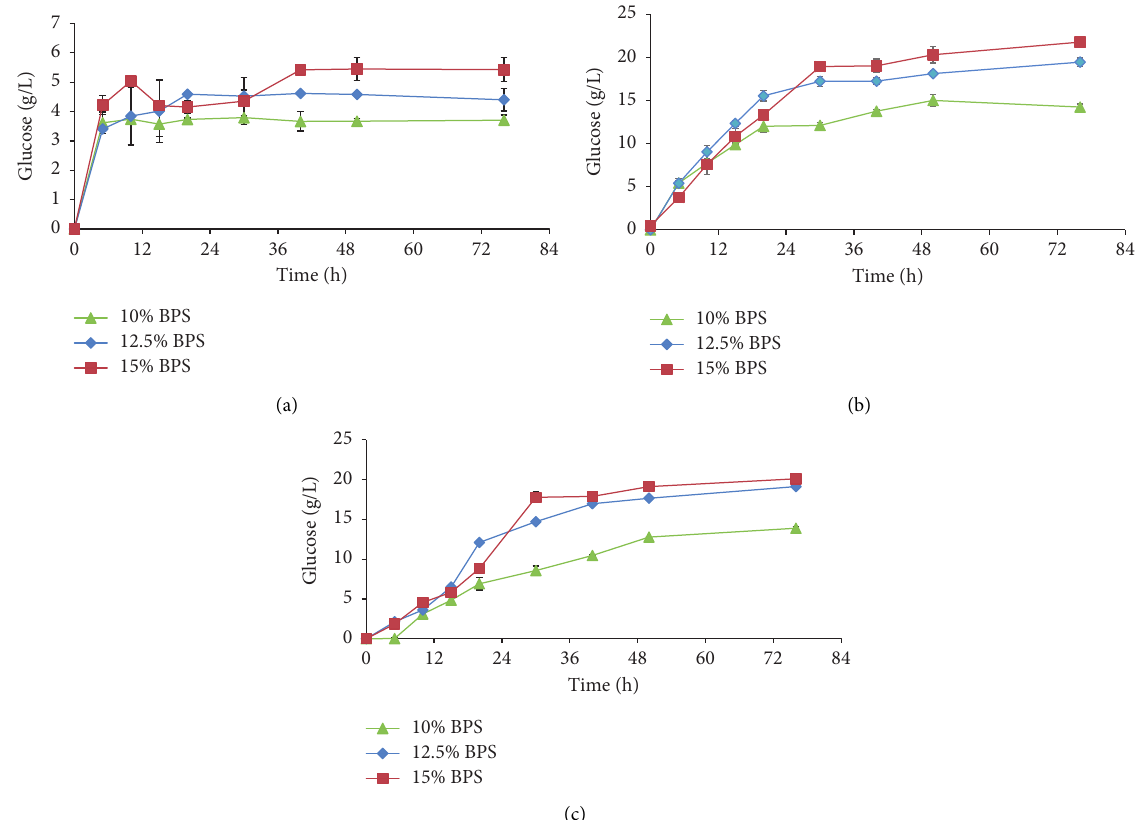
Figure 3: Time course of the pretreated BPS by the crude enzyme from T. harzianum LMLBP07 13-5: (a) acid; (b) LHW; (c) alkaline.